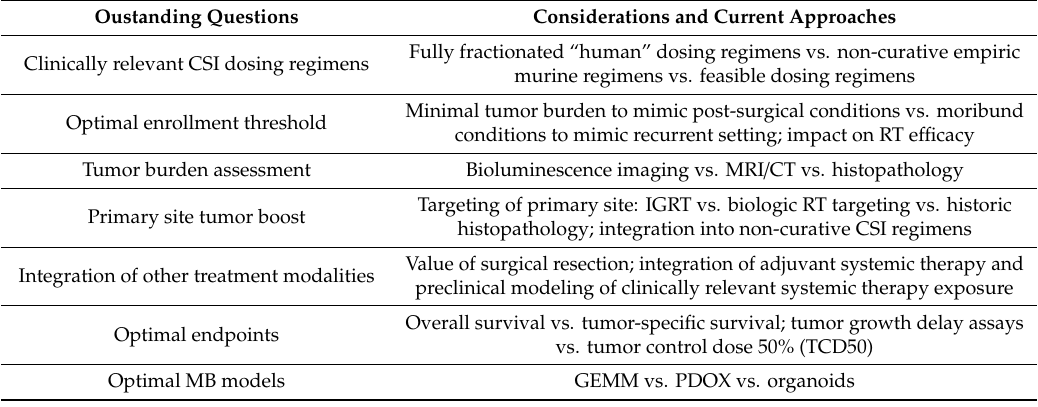
Table 2. Outstanding questions and considerations of preclinical modeling of medulloblastoma and its